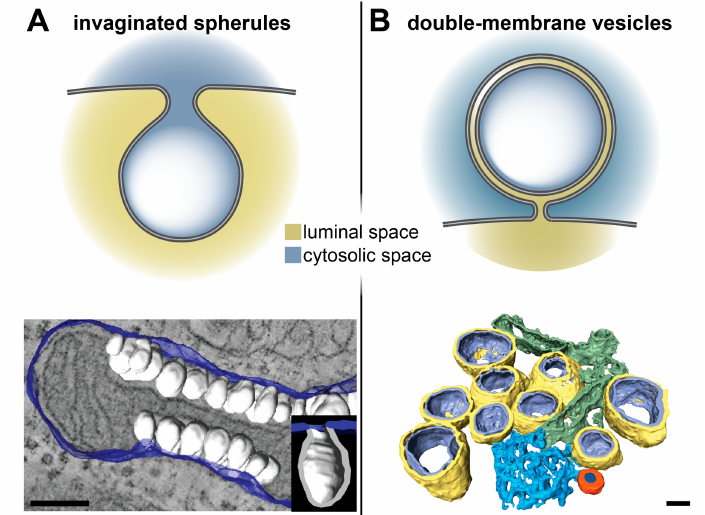
Figure 2. Invaginated spherules and double-membrane vesicles (DMVs) by electron tomogra- phy. +RNA virus-induced replication organelles (ROs) can be divided in two classes—invaginated spherules and elaborate vesicular networks that contain DMVs. ( A ) Nodavirus- and ( B ) coronavirus- induced membrane modifications are representatives of these two classes of ROs. ( Top ) Sketches of the architecture of the invaginated spherules and DMVs induced by these viruses. While the invaginated spherules induced by nodaviruses and other +RNA viruses have neck-like openings that connect their interior with the cytosol, the DMVs induced by coronaviruses appear to define close compartments. ( Bottom ) Segmented tomographic volumes of the membrane alterations induced by the nodavirus flock house virus (FHV) in Drosophila cells and by the Middle East respiratory syndrome coronavirus (MERS-CoV) in Huh7 cells (adapted from [14] and [39], respectively). FHV induced the formation of invaginated spherules (white) in the outer mitochondrial membranes (blue). Coronaviruses ROs include DMVs (outer and inner membranes in yellow and purple, respectively), convoluted membranes (blue), and double-membrane spherules (orange). These coronavirus-induced membrane structures are often interconnected, either directly or through the ER from which they derive. Scale bars, 100